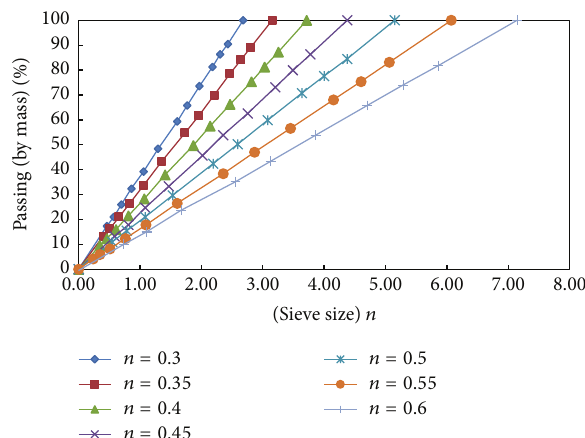
Figure4:Talbot’sgradingcurvemaximumdensitylines(forvarious 𝑛 values) for 19.0 mm nominal maximum size.